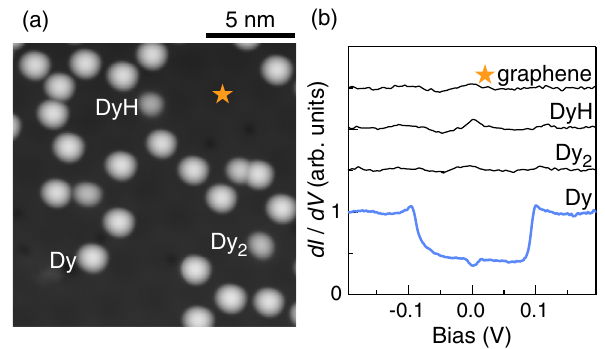
FIG. 8. The dI=dV spectroscopic signatures. (a) STM image acquired on Dy on gr = Ir ð 111 Þ . Labels identify a Dy monomer, a ¼ − 0 . 2 V, Dy dimer, and a hydrogenated Dy. Parameters: V t ¼ 100 pA, T ¼ 6 . 5 K, Θ ¼ 0 . 5% ML. (b) dI=dV spectra I t Dy acquired on a Dy atom, a Dy dimer, a hydrogenated Dy atom, and on the graphene substrate. All spectra are background corrected FIG. 9. Spin-polarized DOS around E and normalized to 1 and vertically offset for clarity. Parameters: Dy, and a 2 p shell of C, for two Dy-graphene adsorption ¼ 150 pA, V ¼ − 0 . 2 V, V ¼ 5 mV peak-to-peak, I distances (4.5 a.u. and 5.0 a.u.). The dashed line marks E set set mod T ¼ 6 . 5 K. All data were acquired using a W tip. smearing of 1 mRy has been